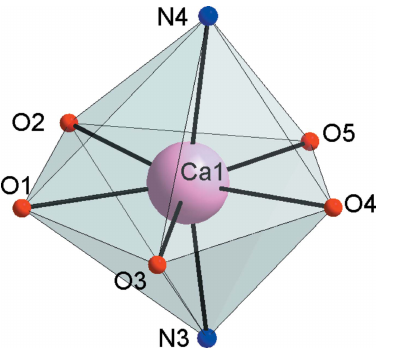
Figure 2 Coordination polyhedron of the calcium atom in the title compound.